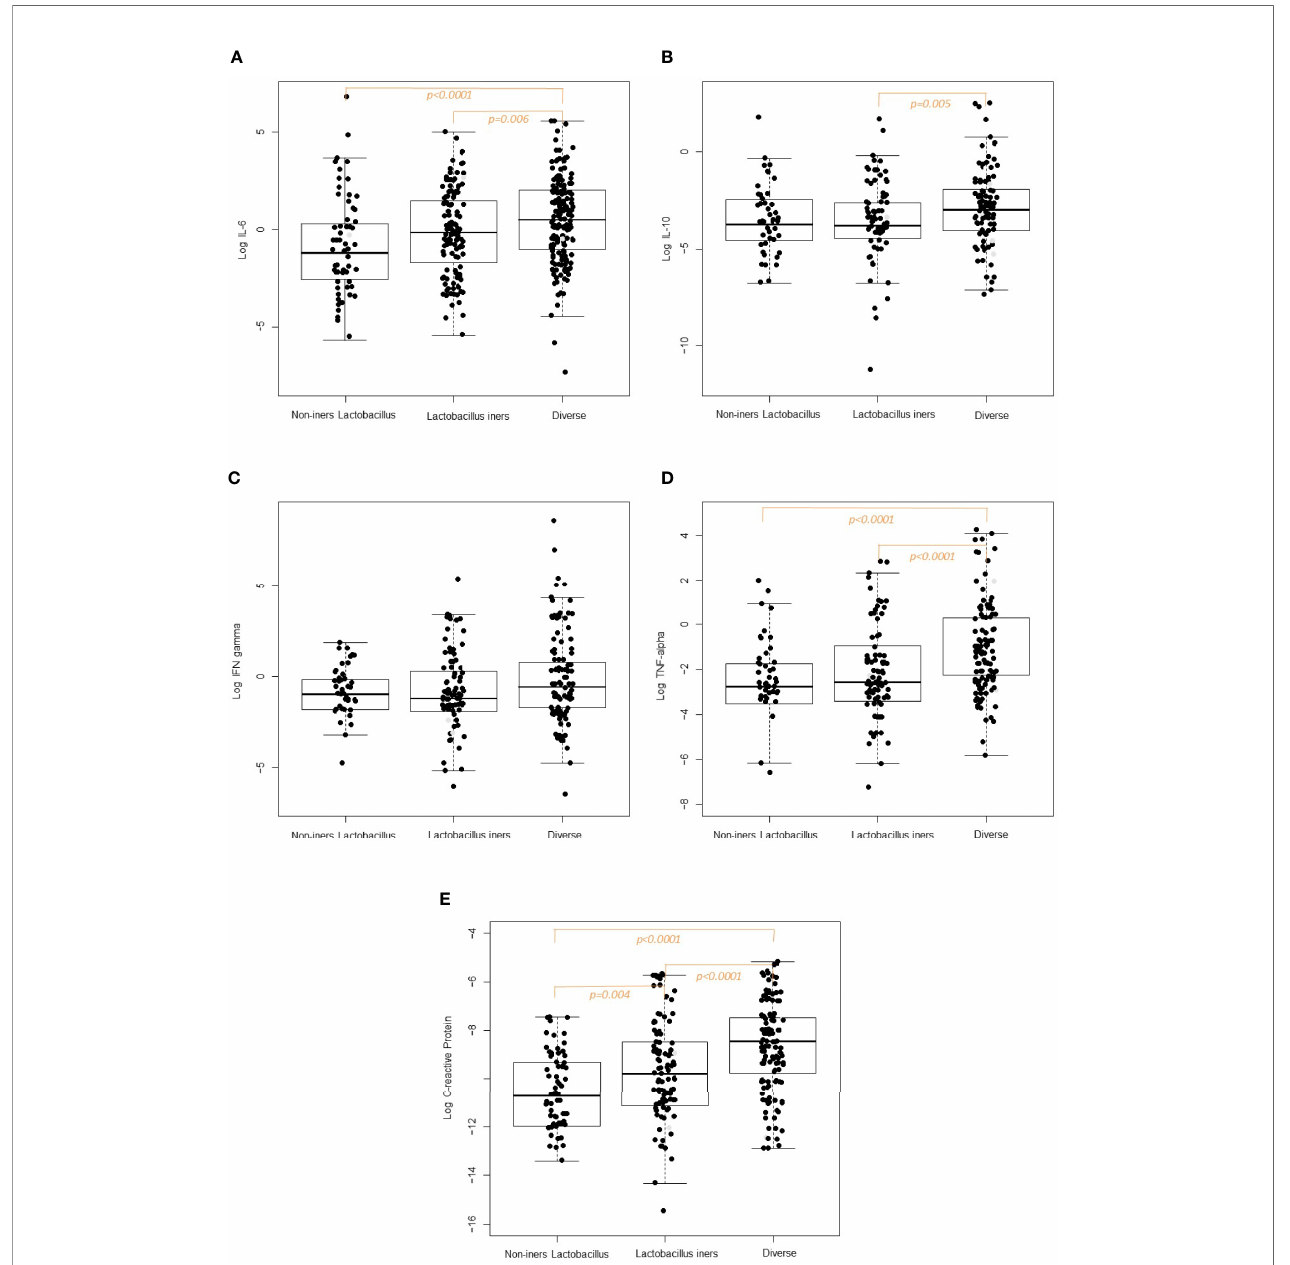
FIGURE 2 | (A) Vaginal Interleukin-6 concentration according to CST category. (B) Vaginal Interleukin-10 concentration according to CST category. (C) Vaginal Interferon-gamma concentration according to CST category. (D) Vaginal TFN-alpha concentration according to CST category. (E) Vaginal C-reactive concentration according to CST